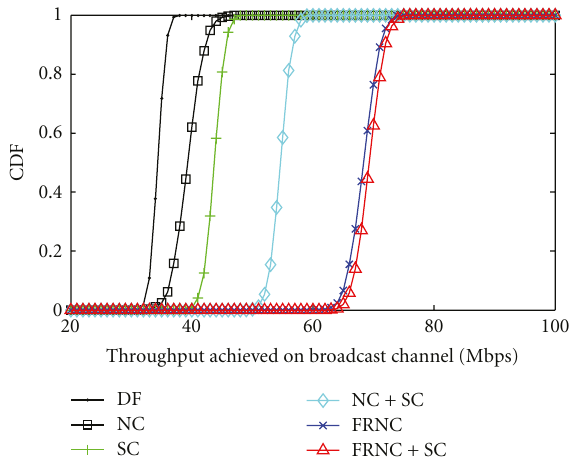
Figure 8: Cumulative density function of throughput achieved on the broadcast channel (normalized distance = 0.3 in Figure 7).